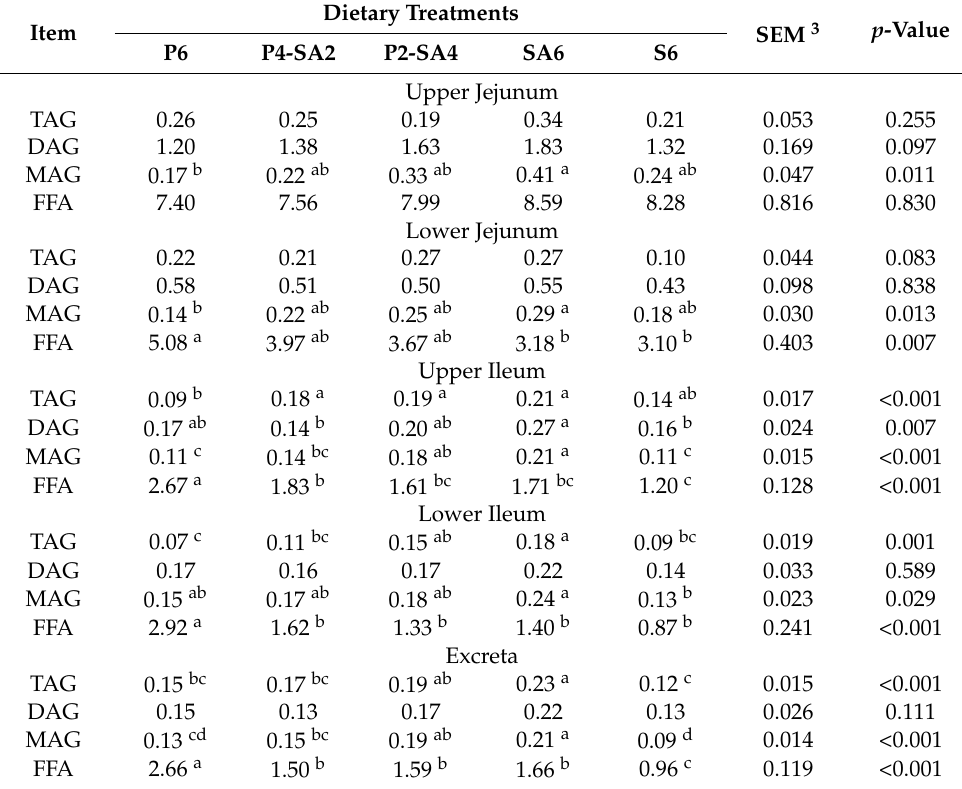
Table 6. Lipid class content 1 in the different intestinal segments and excreta in 35-d-old broiler chickens fed various experimental fat sources in the diet 2